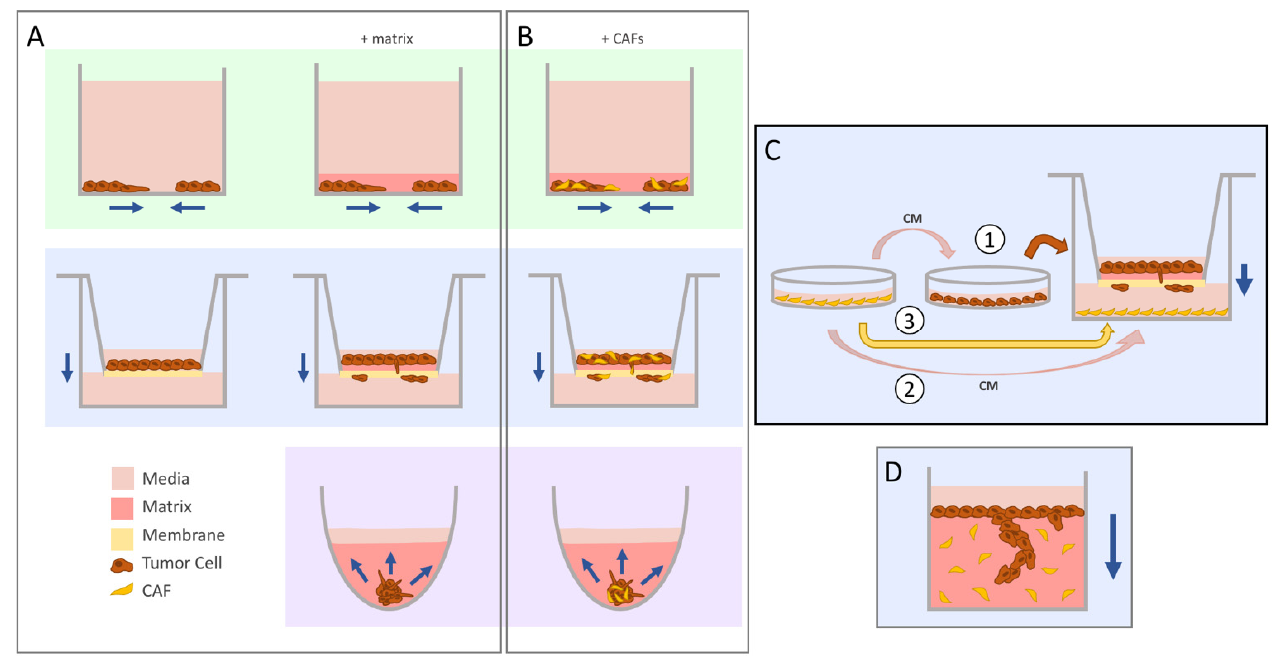
Figure 1. The evolution of migration into invasion assays. Navy arrows indicate the direction of movement by the tumor cells. ( A ) The scratch wound or exclusion zone (green, top) and transwell (blue, middle) assays were commonly used to study migration in vitro. The addition of a matrix for cells to travel through allowed for the seamless conversion of these systems to study invasion instead. Concerns regarding the translatability of 2D cyto-architecture prompted the use of 3D spheroids (purple, bottom), which can be embedded in matrix to evaluate invasion of cells coming out from the aggregate. ( B ) Cancer-associated fibroblasts (CAFs) can be added into these systems by seeding the cells as a co-culture mix. ( C ) There are different ways to study CAF-influenced tumor cell invasion in the transwell set-up. CAF-conditioned media (CM) can be used to pre-treat tumor cells prior to seeding into the insert (1) or added directly to the lower chamber (2). CAFs can also be seeded directly into the bottom chamber (3). ( D ) The vertical gel assay yields high-resolution images of invading cells through sectioning and staining.